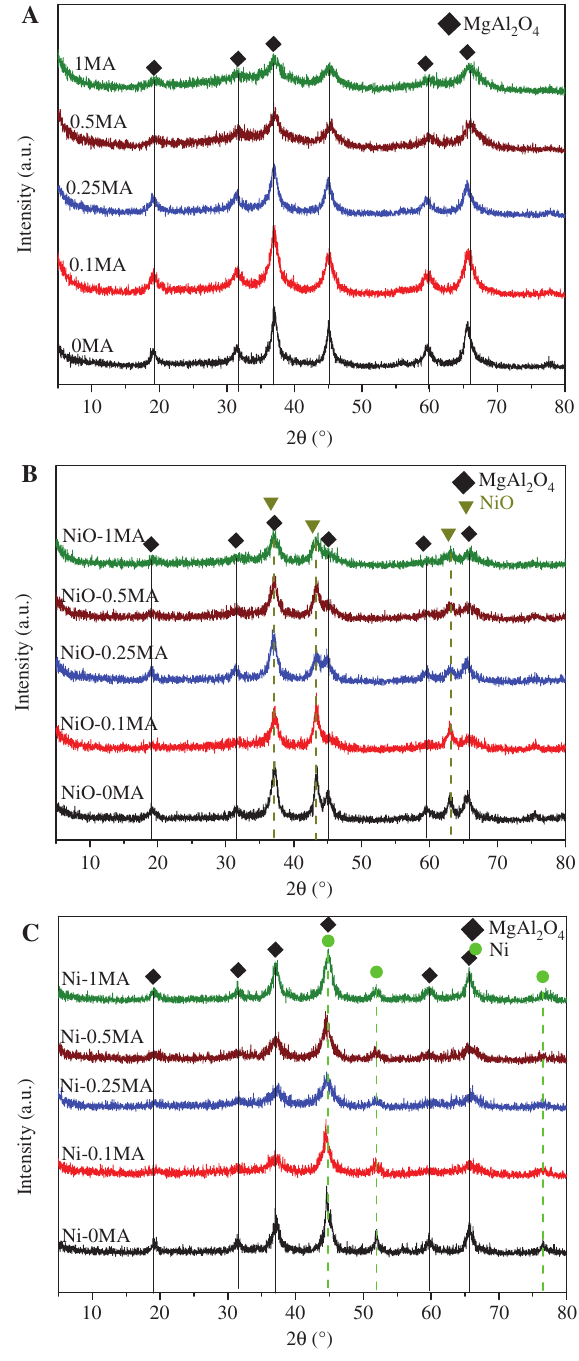
Figure 2: XRD patterns of the catalysts: (A) xMA supports; (B) NiO-xMA catalysts; and (C) 650 ° C-reduced Ni-xMA